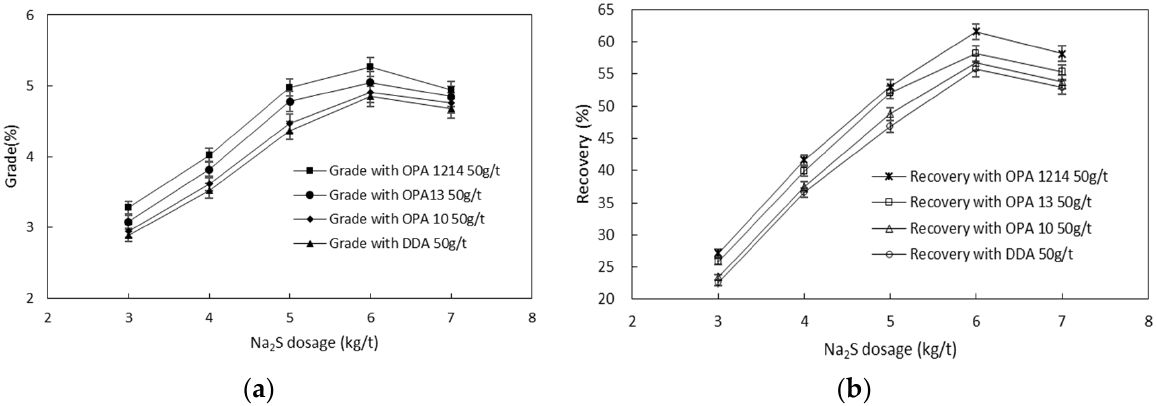
Figure 5. Interactive effect of Na 2 S and the four amines on the concentrate Zn grade ( a ) and recovery ( b ) in smithsonite flotation.